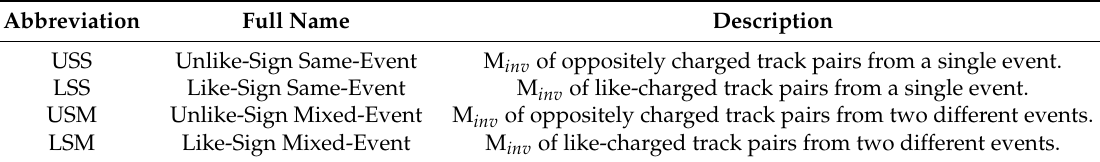
Table 1. Table defining all the M inv distributions used in this